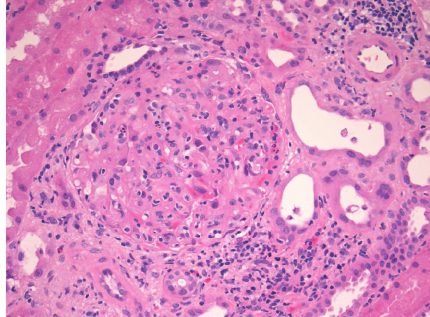
Figure 2: The glomerulus is hypercellular, with an increased num- ber of polymorphonuclear and mononuclear inflammatory cells (hematoxylin and eosin